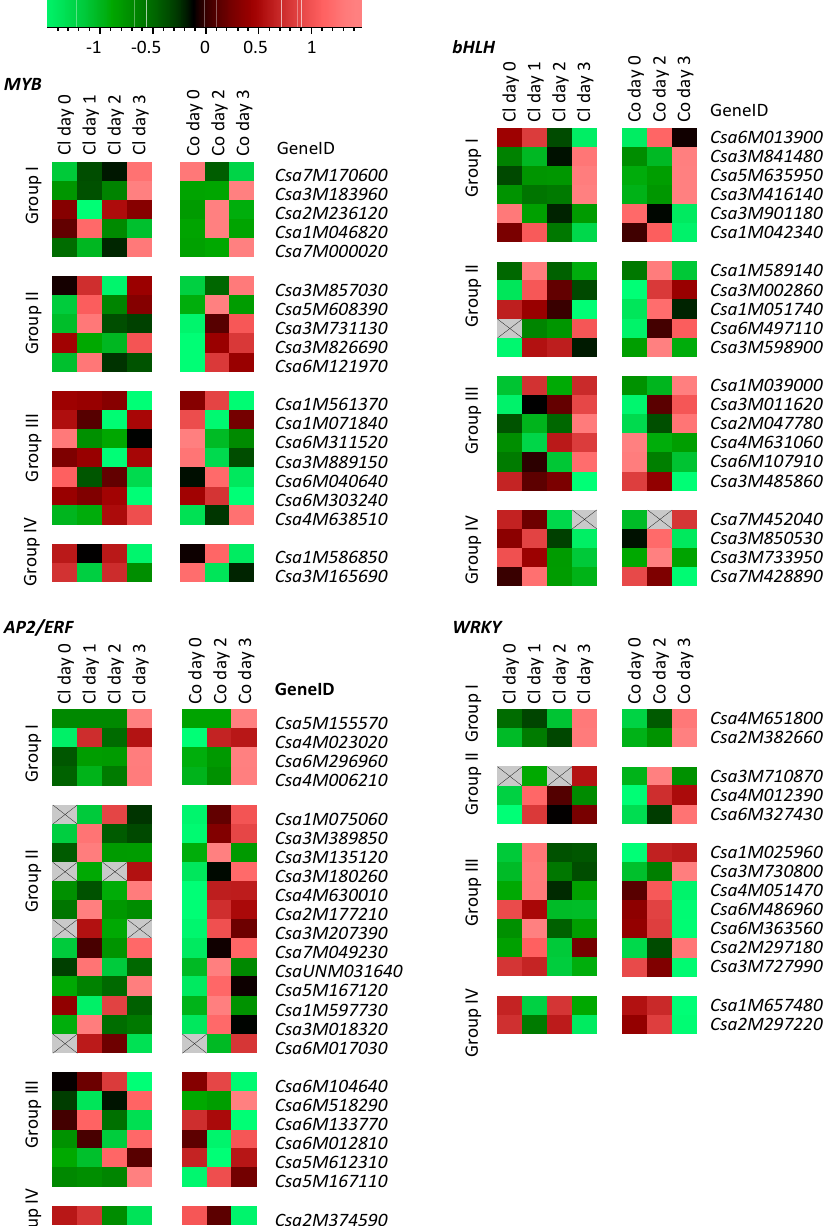
Figure 3. Expression profiling of cucumber transcription factors of four families most differentially regulated by spider-mite feeding ( T. urticae ). Reads Per Kilobase of transcript per Million mapped reads (RPKM) values of the genes obtained from RNA-seq were introduced into Genemaths XT and were normalized to the standard deviation of each gene. Color coding: green represents low expression; red represents high expression. Grey squares with cross indicate that no transcripts were detected.